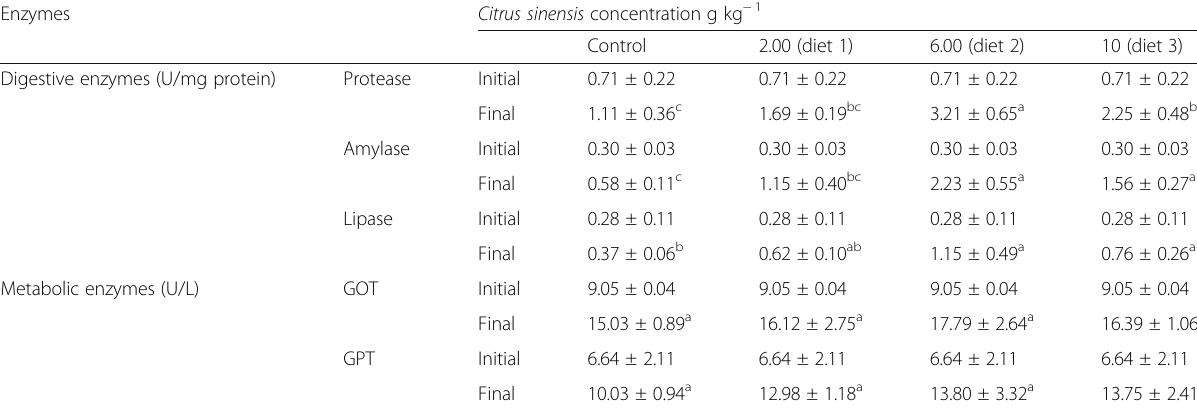
Table 4 Activities of digestive and the metabolic enzymes (U/mg protein) in Catla catla fed with different concentration of Citrus sinensis -supplemented diets Enzymes